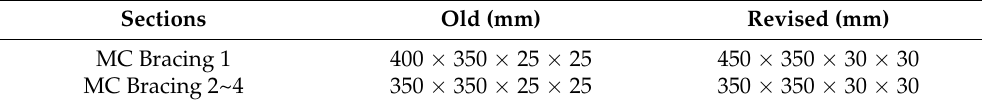
Table A11. Revised Section of MC Bracing 1 and MC Bracing 2~4.